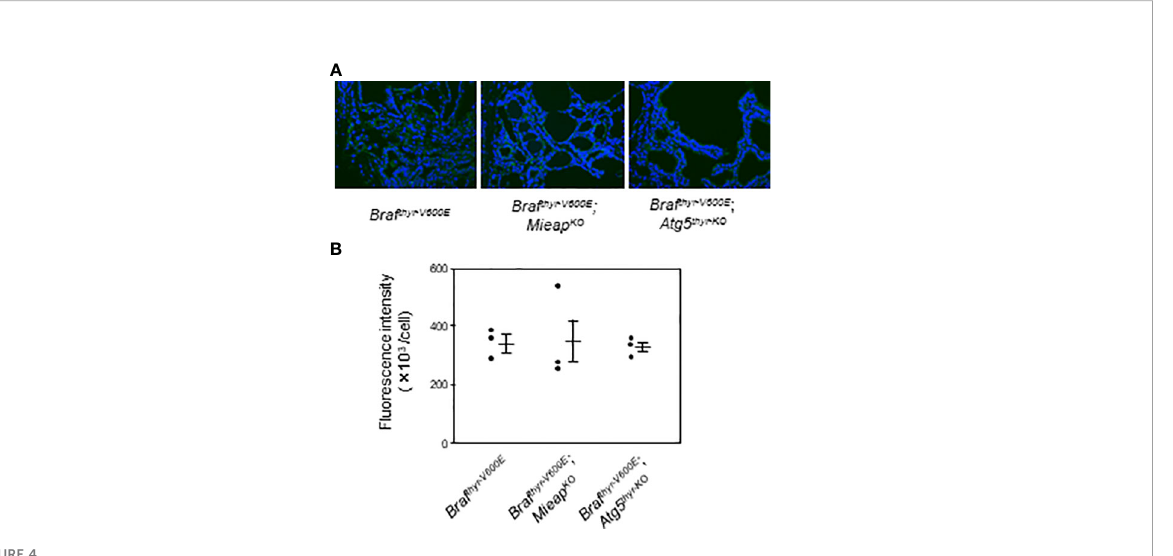
FIGURE 4 IHC staining for TOMM20 expression (A) and quanti fi cation of fl uorescence intensities (B) in the thyroids from Braf thyr – V600E , Braf thyr – V600E , Mieap KO/KO , and Braf thyr – V600E , Atg5 thyr – KO/KO mice. The thyroid tissues obtained in Figure 1 were used for IF as described in Materials and methods . The original magni fi cations were ×400. Data are shown as black circles for individual mice and as means ± SE. M,